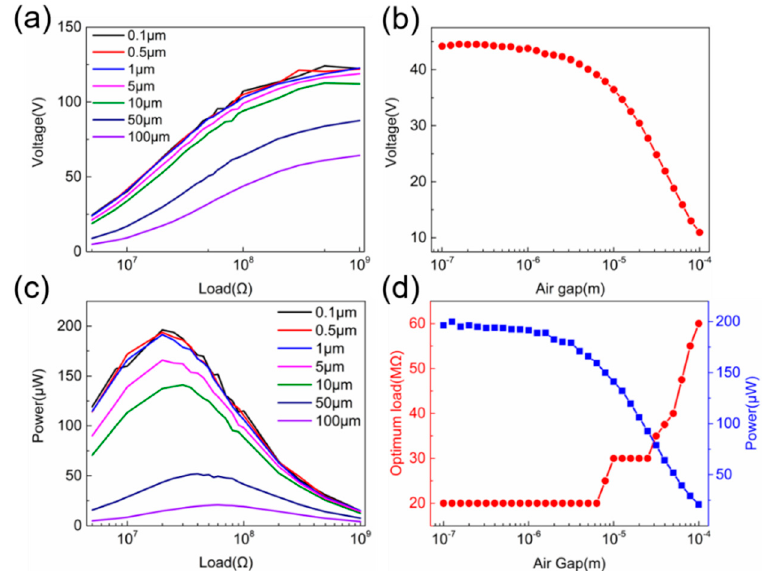
Figure 3. Simulated ( a ) voltage and ( c ) power output when the thickness of air gap increases from 0.1 to 100 µ m; ( b ) summarized peak voltage at a 1-M Ω external load with increasing air gap thickness; and ( d ) summarized peak power and correspondence optimum load under increasing air gap.